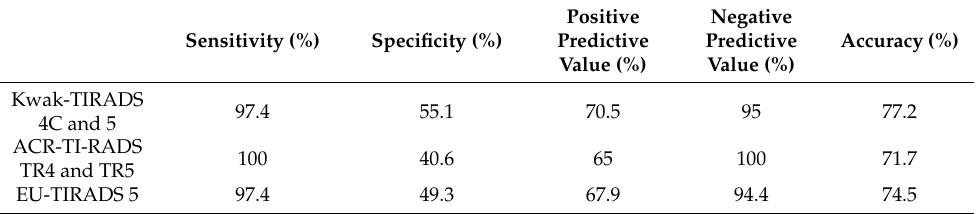
Table 3. Diagnostic performance of Kwak-TIRADS, EU-TIRADS, and ACR